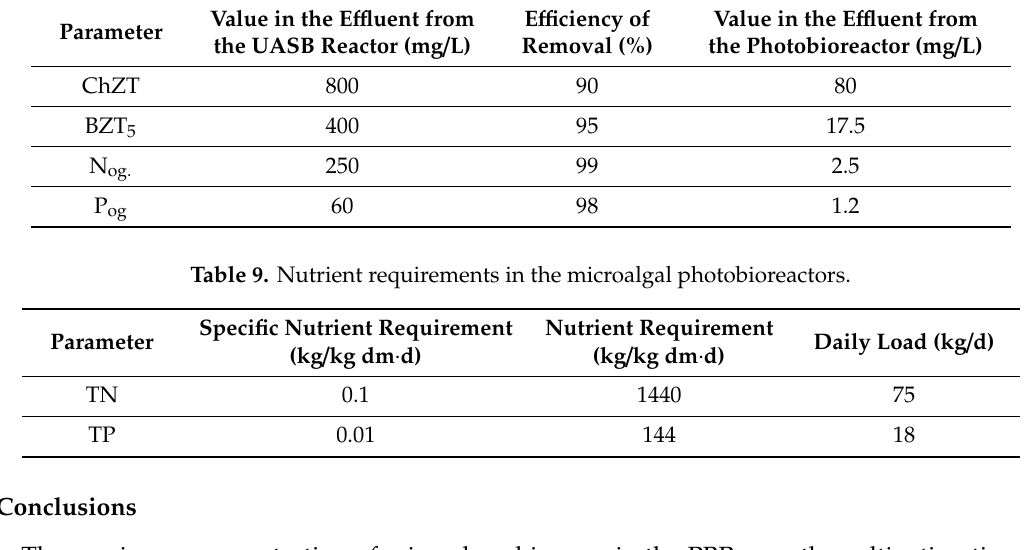
Table 8. Characteristics of the e ffl uents from the UASB reactor and photobioreactor.